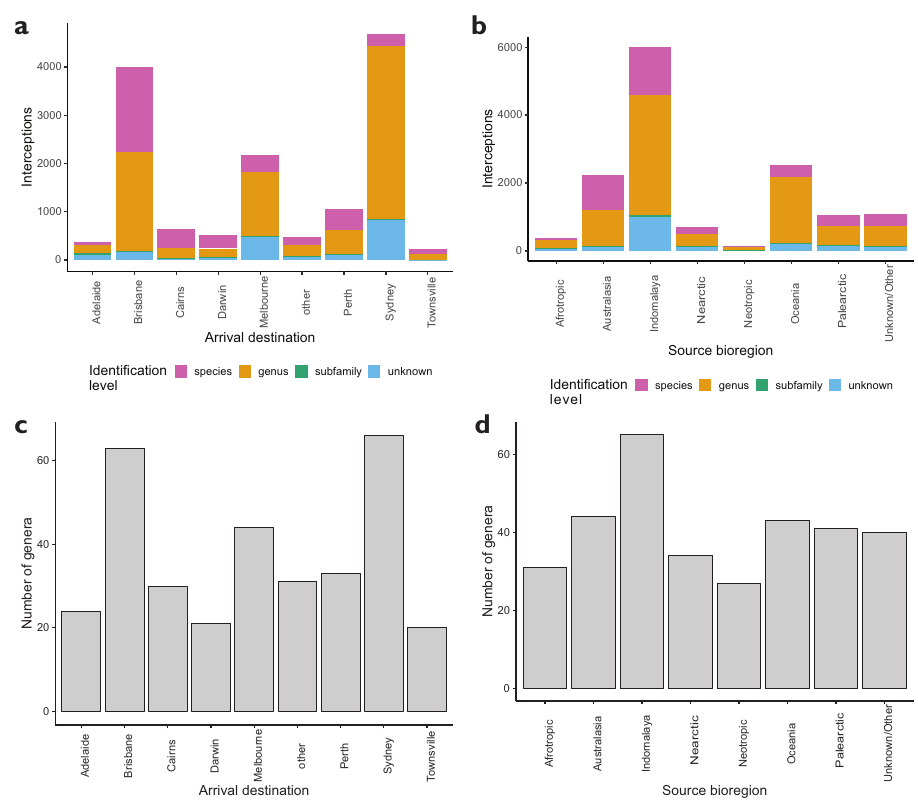
Figure 2. Taxonomic patterns of Australian ant interception data. Taxonomic level identified for in- terceptions separated by ( a ) city of arrival (e.g., port of entry) and ( b ) source biogeographic region. The number of genera identified in interceptions by ( c ) city of arrival and ( d ) source